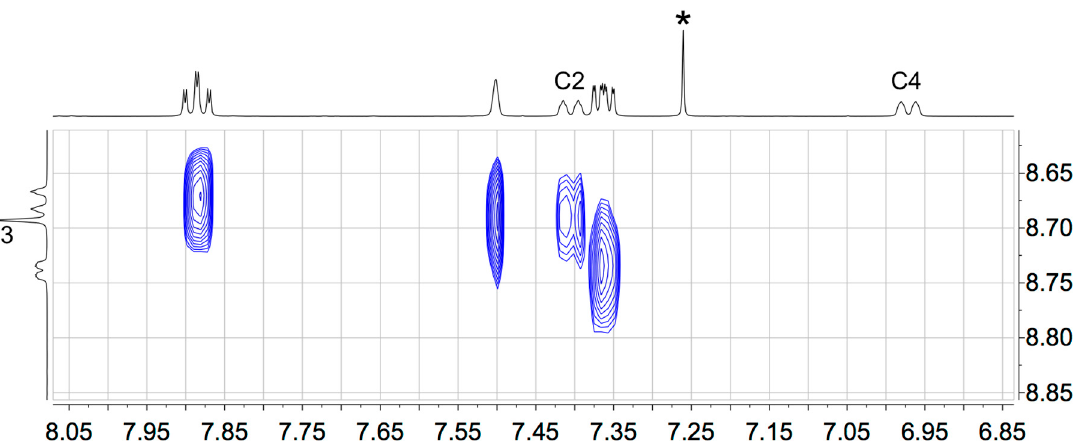
Figure 3. 13 C{ 1 H} NMR spectrum (126 MHz, CDCl 3 ) of compound 4 . ( a ) Full spectrum with solvent reference, * = CDCl 3 . ( b ) Expansion of the signals for nuclei C C2 and C C4 . ( c ) Expansion of the signal for C C3 . Chemical shifts in δ / ppm. Figure 4 displays the solution absorption spectra of compounds 2 – 5 . The absorptions are assigned to spin-allowed π * ←π transitions in 2 , and to π * ←π and π * ← n transitions in 3 , 4 and 5 . On going from 2 to 3 to 4 , the change from 3,5-dimethylphenyl to 3-fluoro-5-methylphenyl to 3,5-difluorophenyl substituent leads to a dominance of the highest energy absorption around 253